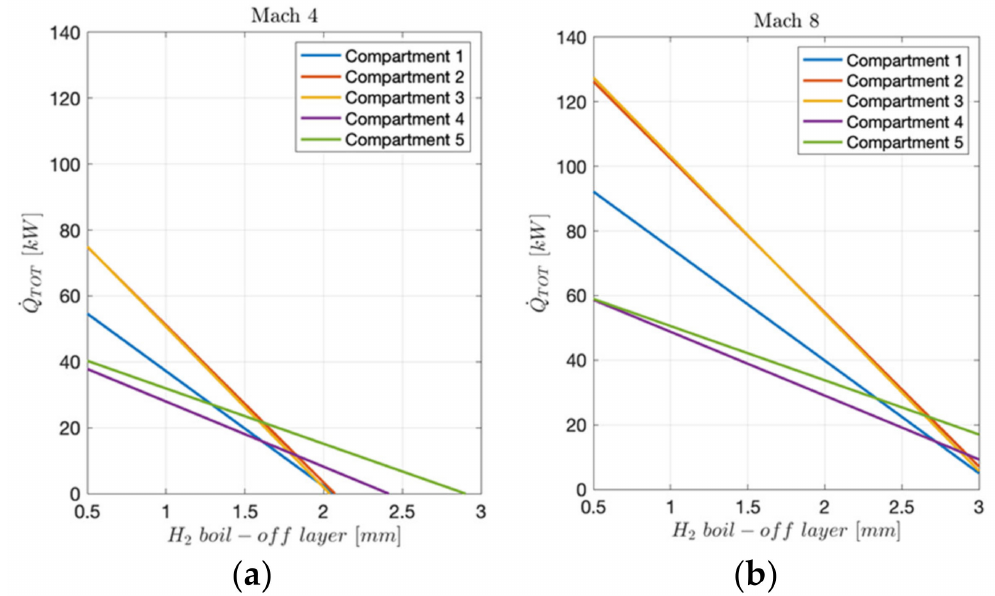
Figure 18. ( a ) Variation of the total heat loads with the thickness of the hydrogen boil-off insulation layer per each cabin compartment at Mach 4 flight condition; ( b ) variation of total heat loads with the thickness of the hydrogen boil-off insulation layer per each cabin compartment at Mach 8 flight